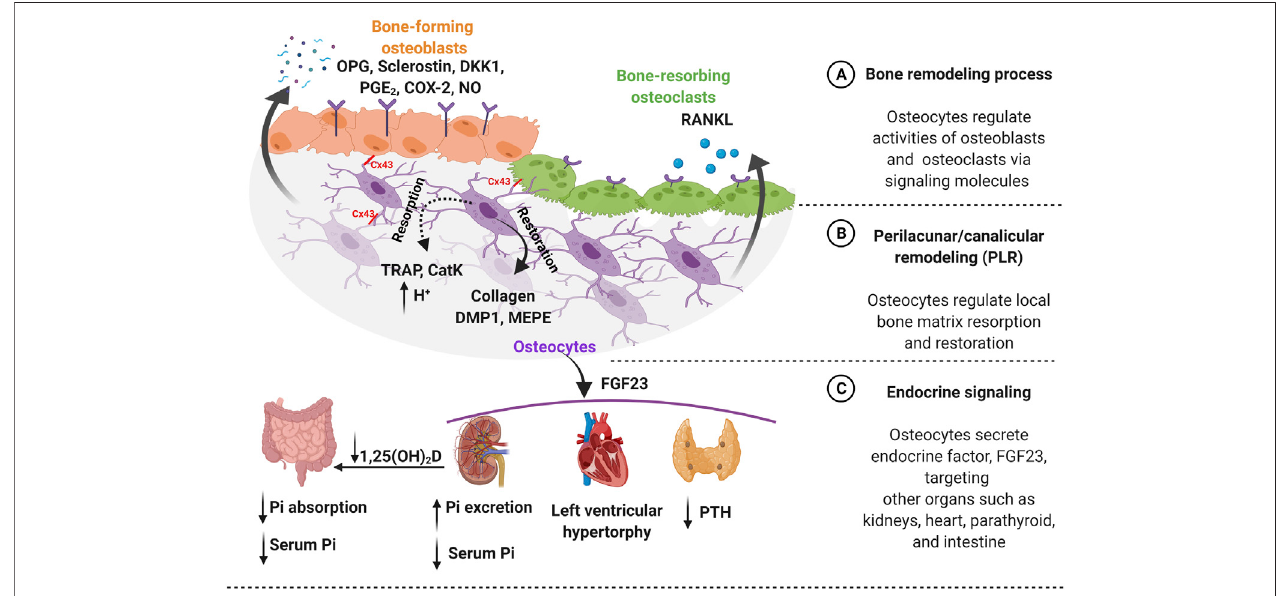
FIGURE 1 | Osteocytes function in both bone homeostasis and endocrine signaling. (A) Bone homeostasis is guided by osteocytes, which require a precise balance of bone formation and bone resorption. Osteocytes regulate this dynamic equilibrium by releasing signaling molecules such as osteoprotegerin (OPG), sclerostin, dickkopf-related protein 1 (DKK1), prostaglandin E2 (PGE 2 ), cyclooxygenase-2 (COX-2), and nitric oxide (NO) for bone-forming osteoblasts. Furthermore, osteocytes secrete receptor activator of nuclear factor- κ B ligand (RANKL) for bone-resorbing osteoclasts on the bone surface. Additionally, osteocytes mediate communicationwithosteoblastandosteoclastviaconnexin43(Cx43)gapjunctions. (B) Osteocytesregulatethelocalbonematrixthroughaprocesscalledperilacunar/ canalicular remodeling (PLR). Matrix resorption (dotted line) is initiated creating an acidic environment by osteocyte-derived enzymes, such as tartrate-resistant acid phosphatase (TRAP) and cathepsin K (CatK) followed by matrix restoration (solid line), by producing collagen and bone matrix proteins such as dentin matrix protein 1 (DMP1)and matrix extracellularphosphoglycoprotein (MEPE). (C) Osteocytes secretean endocrine factor - fi broblast growth factor (FGF23) totarget otherorgans such as kidneys, heart, and parathyroid. The FGF23 hormone triggers parathyroid to reduce the level of parathyroid hormone (PTH). Moreover, FGF23 increases the risk of heart failure such as left ventricular hypertrophy. Importantly, FGF23 regulates serum phosphate (Pi) level by targeting kidneys by increasing phosphate excretion and also inhibiting the conversion of active vitamin D to 1,25-dihydroxy vitamin D [1,25(OH) 2 D] in the intestine to decrease phosphate resorption leading to lower serum phosphate level. Figure created using BioRender.